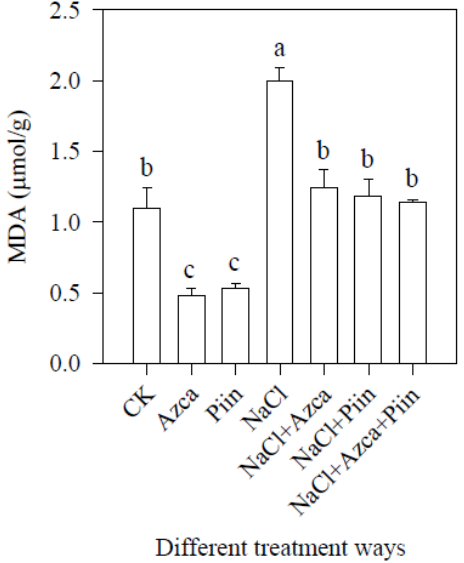
Figure 9. Changes in MDA concentrations in leaves of tomato plants under different treatments. Results were shown as mean ± SE ( n = 3). The means with identical lowercase indicate insignificant differences ( p >